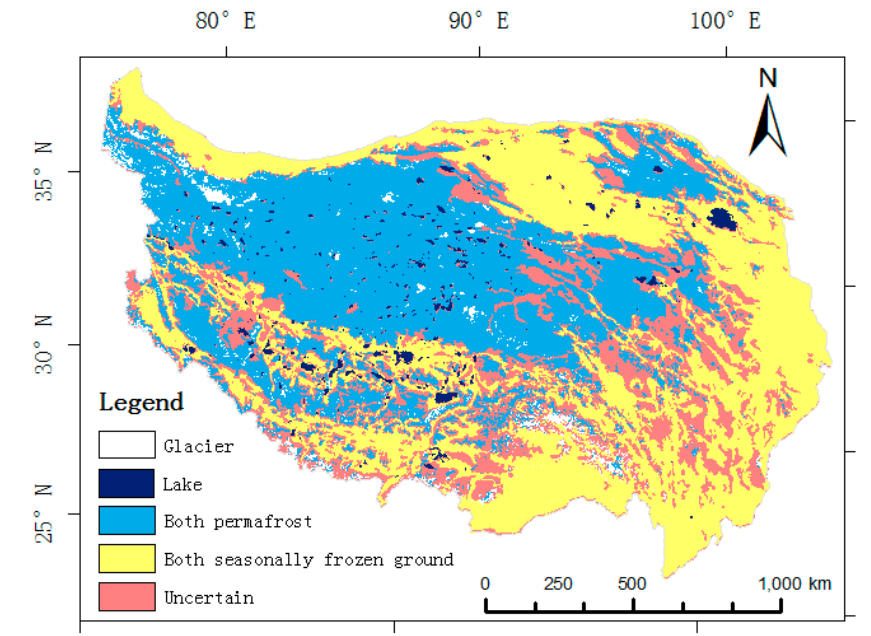
Figure 4. Reclassification of the QTP permafrost map based on the two permafrost maps.